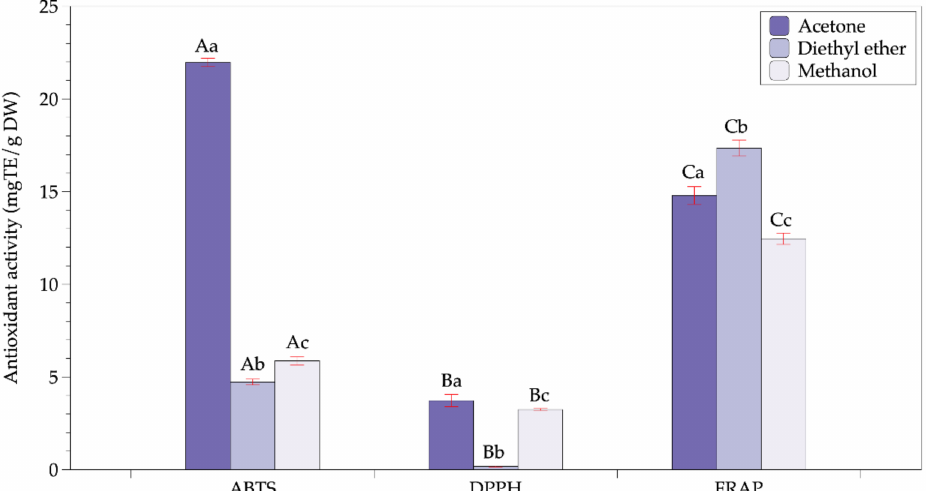
Figure 3. Effects of solvents on the antioxidant activity of avocado extracts. Note: capital letters represent the same group of responding variables, and values within a group with the same lowercase letters are not significantly different ( p >